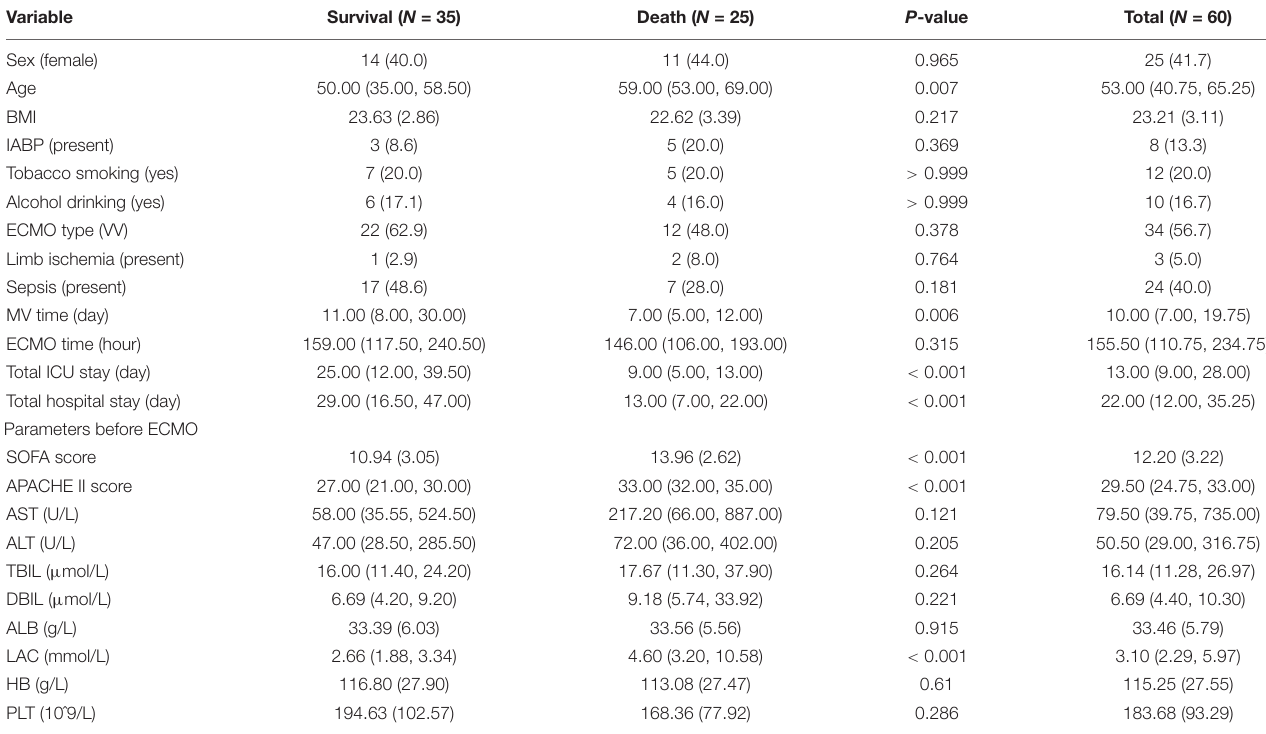
TABLE 1 | Baseline characteristics of the included patients stratified by 28-day mortality.